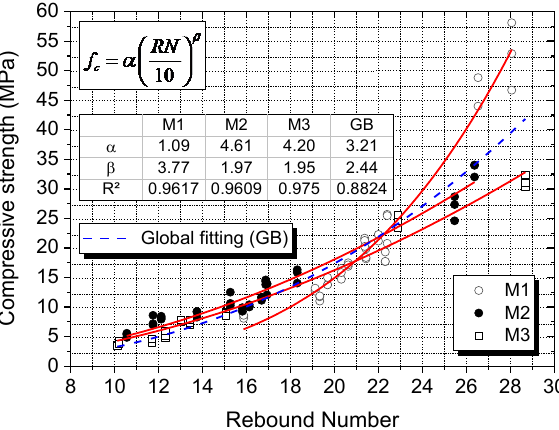
Figure 8 – Correlation between compressive strength and rebound number in phase